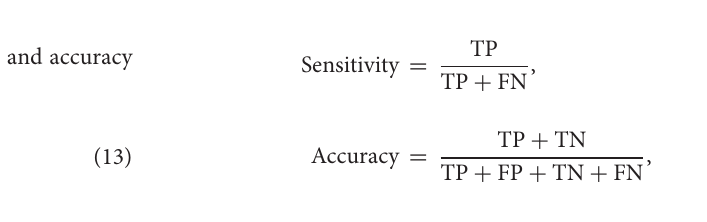
FIGURE 5 | AUC values for different window lengths. (A) AUC values of the entropies for discrimination between normal and ictal and (B) between interictal and